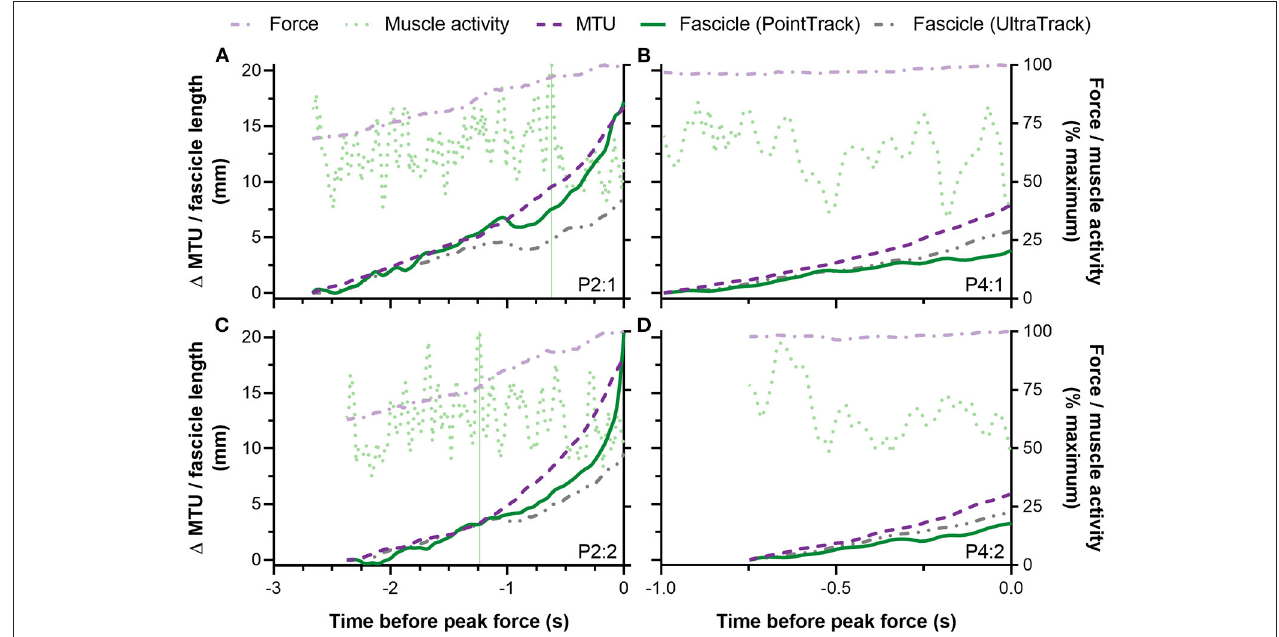
FIGURE 6 | Individual traces from two participants (A–D) showing left-sided biceps femoris long head (BF) fascicle length and muscle-tendon unit (MTU) length changes (left y-axis) and normalized external reaction forces and BF EMG root-mean-square amplitudes (right y-axis) during the Nordic hamstring exercise (NHE) up until peak force. The top panels (A,B) show data from the NHE trial with the highest peak force, and the bottom panels (C,D) show data from the NHE trial with a similar, but lower peak force ( < 5% difference). Only the data from the top row were included in the statistical analysis. Note the similar patterns of fascicle and MTU length change and rates of force development between trials from the same participant. Also note the similar fascicle length changes determined from the same tracking algorithm between trials from the same participant. The vertical green lines in (A,C) show the difference in maximum BF muscle activity timings relative to peak force between two trials from the same participant. The other participant (B,D) did not attain their maximum BF muscle activity over the period when fascicle lengths were tracked in either